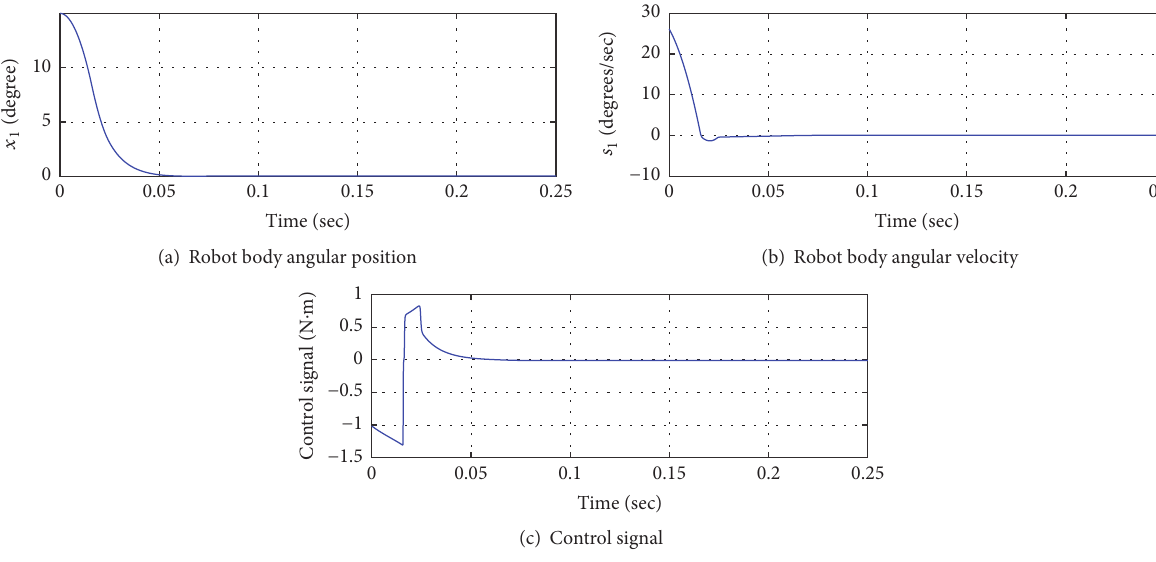
Figure 11: Fuzzy logic sliding mode controller with respect to initial condition, 𝜃 = 15 ∘ and